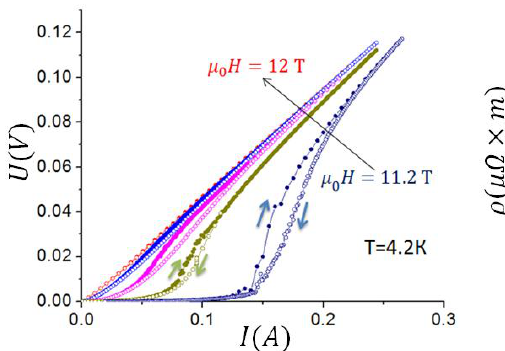
Fig. 1. A series of VCCs for the cold-rolled Nb- Ti tape. The external magnetic field is perpendicular to rolling and lies in the plane of the tape. The value of the magnetic field varies in the range from 11.2 T to 12 T in steps of 0.2 T. Upper critical field for this geometry is μ 0 H c2 = 11.9 T [3].